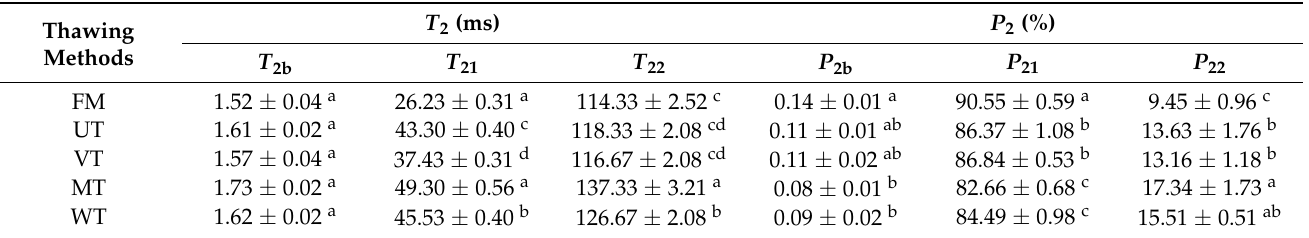
Table 4. Change in distribution of the T 2 relaxation time and the P 2 ( T 2 peak ratio) of porcine longissimus dorsi induced by thawing methods.